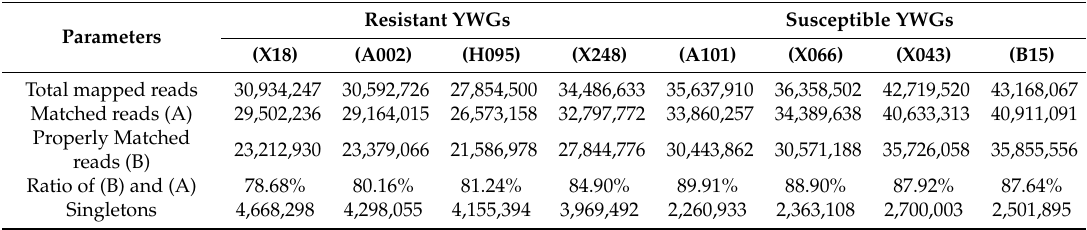
Table 2. The summary of the RNA sequencing analysis data from peripheral blood samples of resistant and susceptible goats.